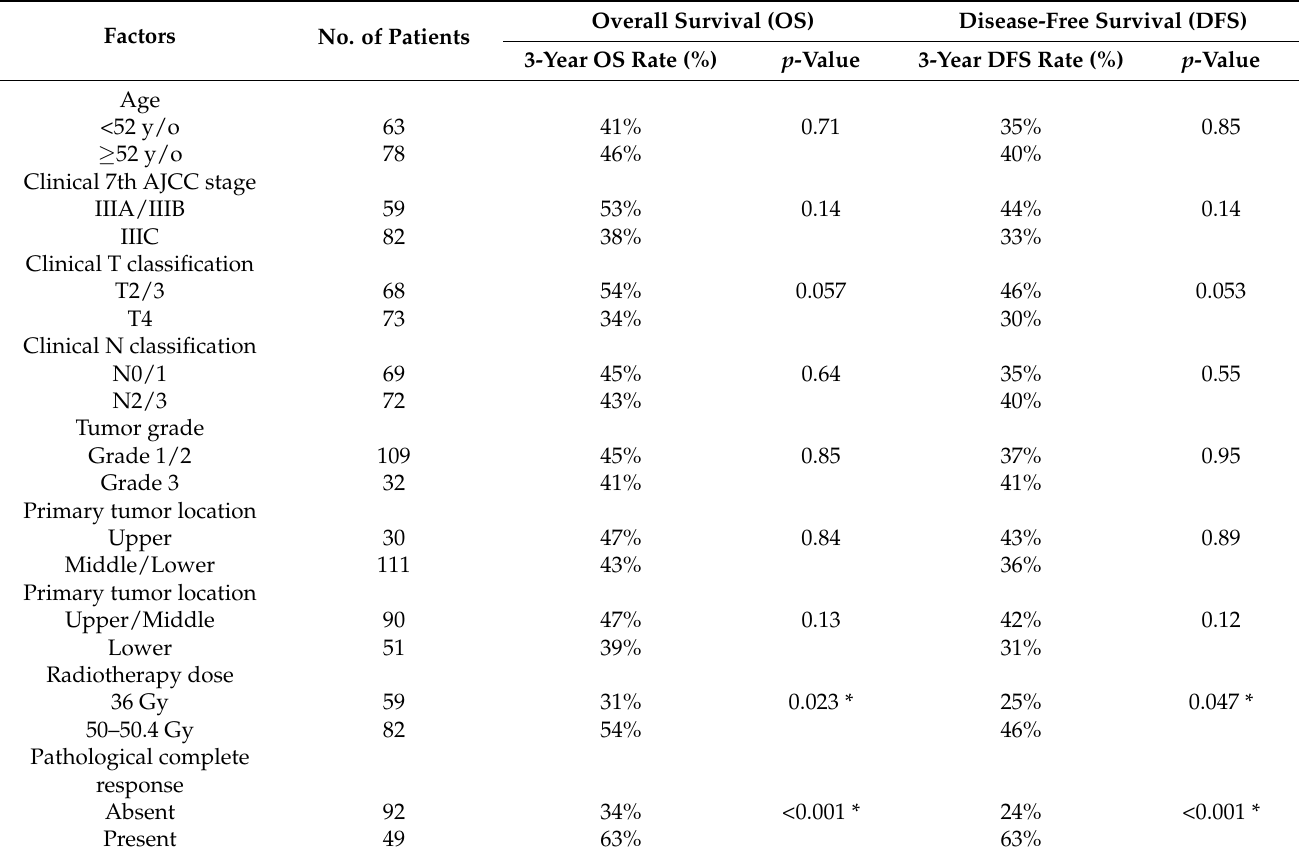
Table 4. Results of univariate analysis of prognostic factors for overall survival and disease-free survival in 141